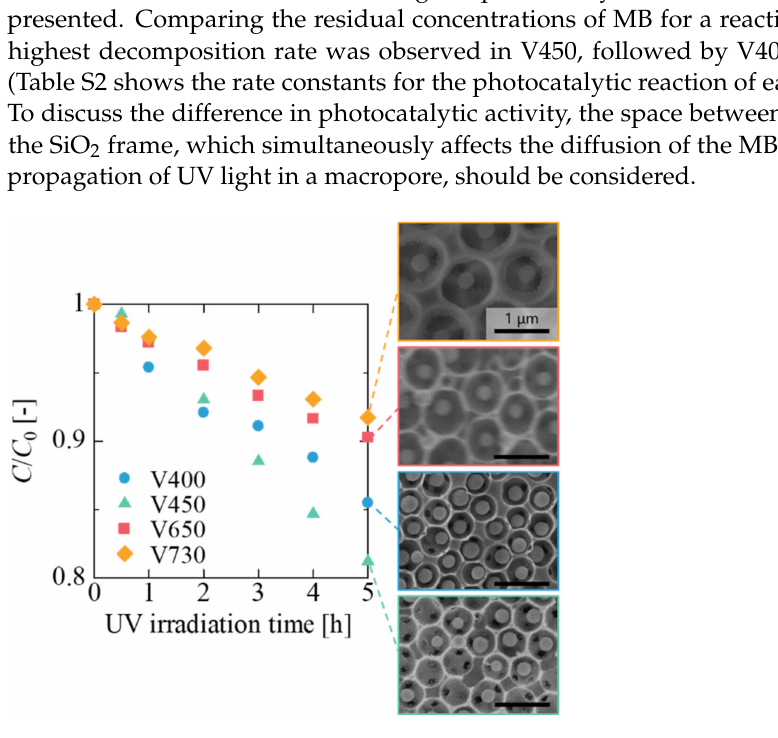
Figure 3. Photocatalytic activities of DIO assemblies with different diameters of macropores. V400 ( d p = 400 nm, blue dots), V450 ( d p = 450 nm, green triangles), V650 ( d p = 650 nm, red squares), V750 ( d p = 730 nm, yellow rhombuses). SEM images on the right are top views of each